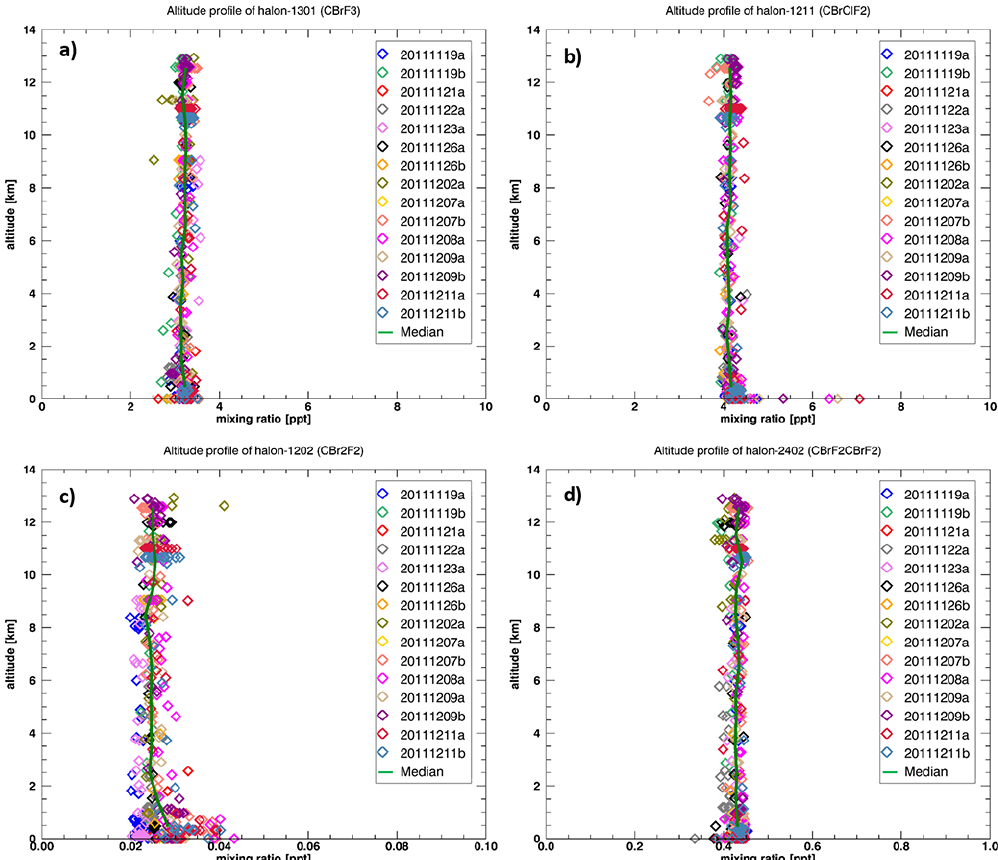
Figure 8. As Fig. 3, for H-1301 (a) , H-1211 (b) , H-1202 (c) and H-2402 (d)